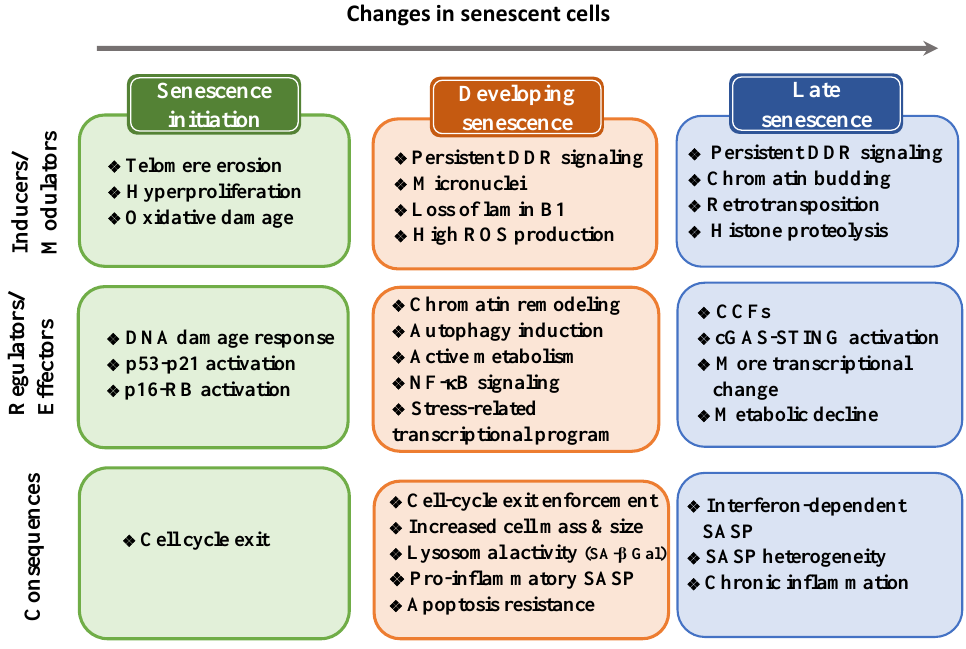
Figure 2. Summary of the most common senescence inducers and alterations observed at initi- ation, developing, and late senescence. CCFs, cytoplasmic chromatin fragments; cGAS-STING, cyclic GMP–AMP synthase-stimulator of interferon genes; DDR, DNA damage response; ROS, reac- tive oxygen species; SA- β Gal, senescence-associated β galactosidase; SASP, senescence-associated secretory